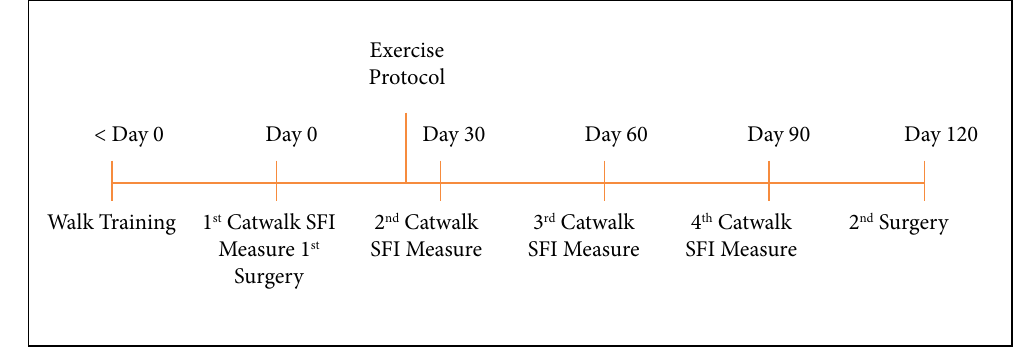
Figure 1 - Timeline of